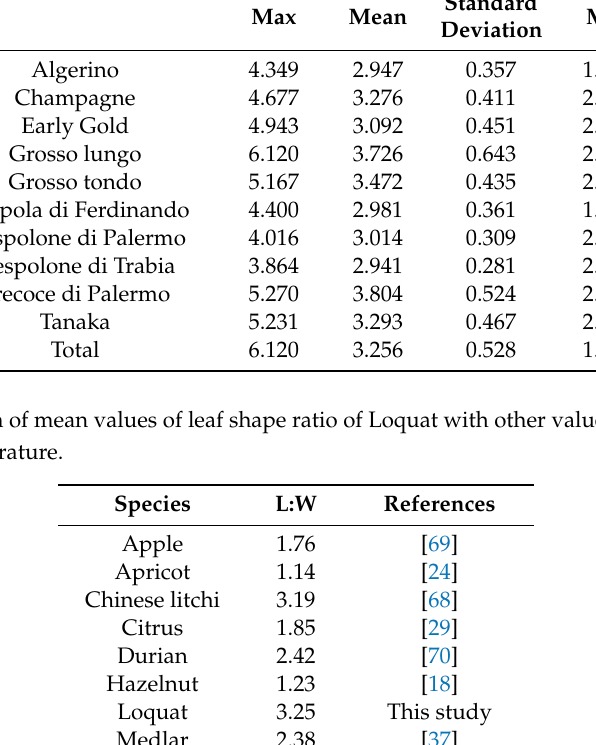
Table 2. Characteristics of the leaf shape ratio (L:W) from di ff erent cultivars used in this study. Cultivar